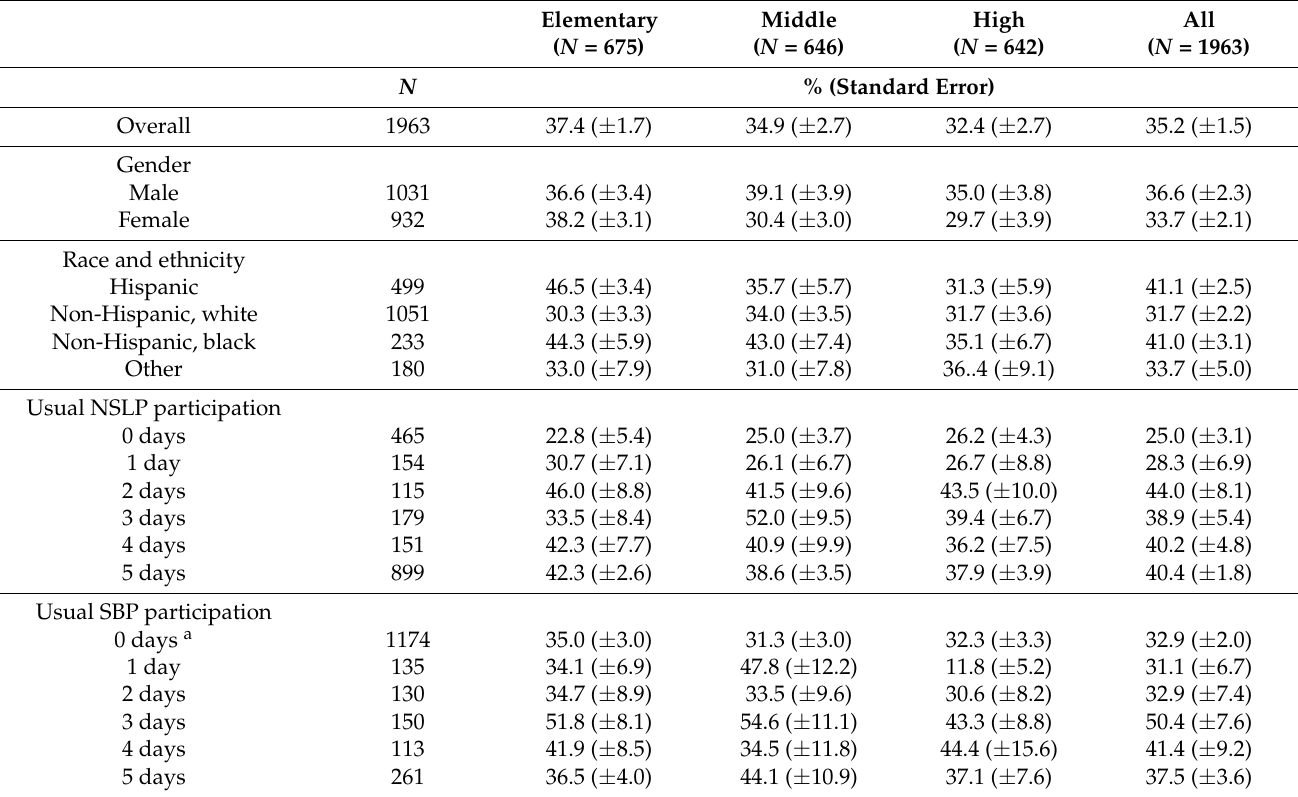
Table 3. Percentage of school-age children classified as overweight or obese, by school